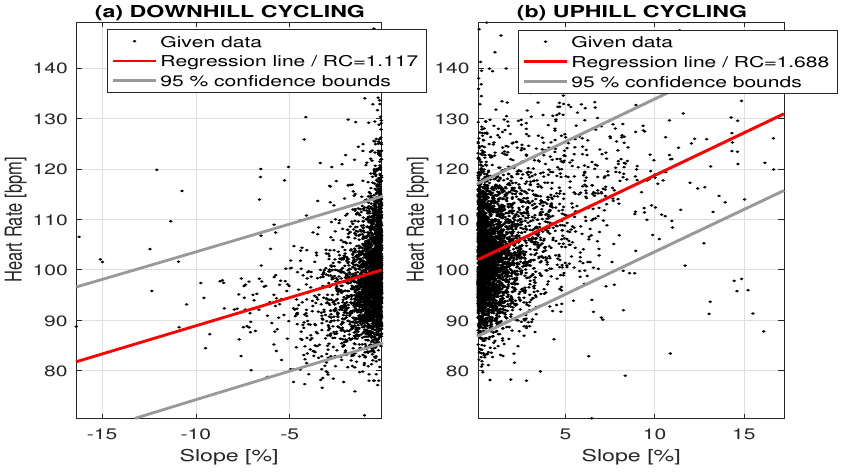
Figure 5. The evolution of the heart rate related to the slope in selected 10-min segments: ( a ) downhill cycling; ( b ) uphill cycling.